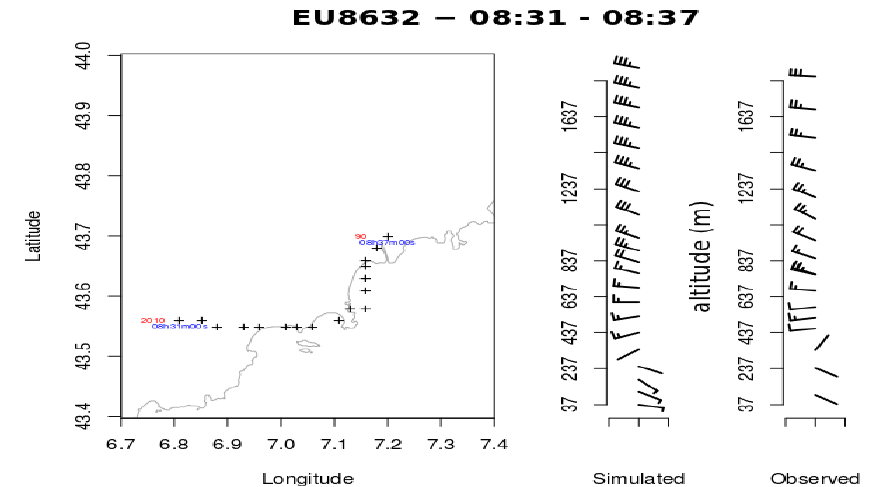
Fig. 8. Graphical representation of the AMDAR message recorded at 08:37UTC on 27 March at the Nice airport. The “+” represents the geographical position of the plane and the altitude and time of observation are given by red and blue values, respectively. The simulated and observed wind barbs (kt) on the right correspond to the wind at each “+”